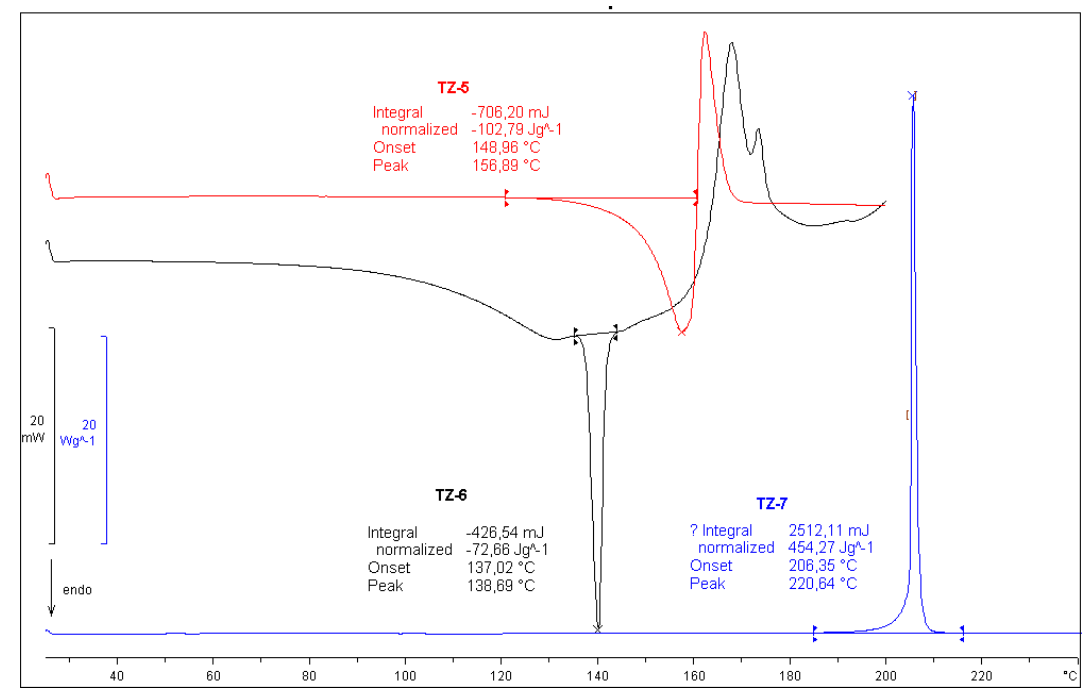
Figure 6. DSC curves of TZ-5 , TZ-6 and TZ-7